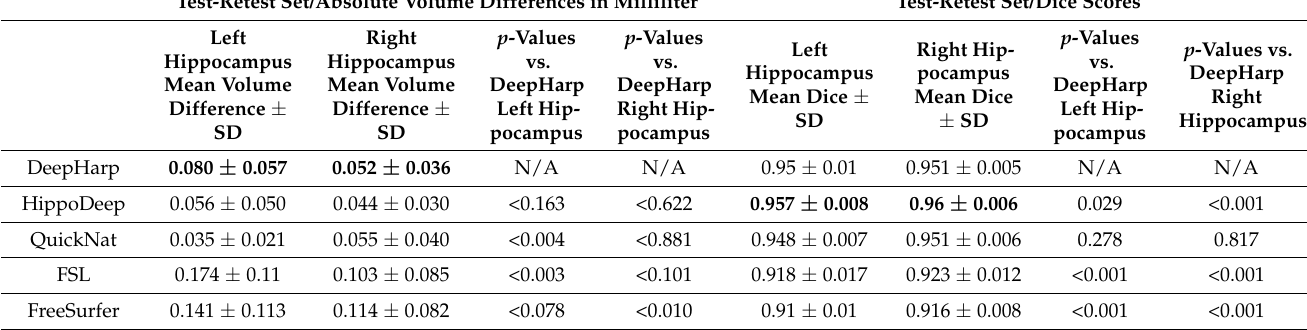
Table 3. Comparison of DeepHarp with other tools regarding robustness. The bold numbers in second and third columns show DeepHarp results. The bold numbers in sixth and seventh columns show highest robustness Dice scores belonging to HippoDeep. Test-Retest Set/Absolute Volume Differences in